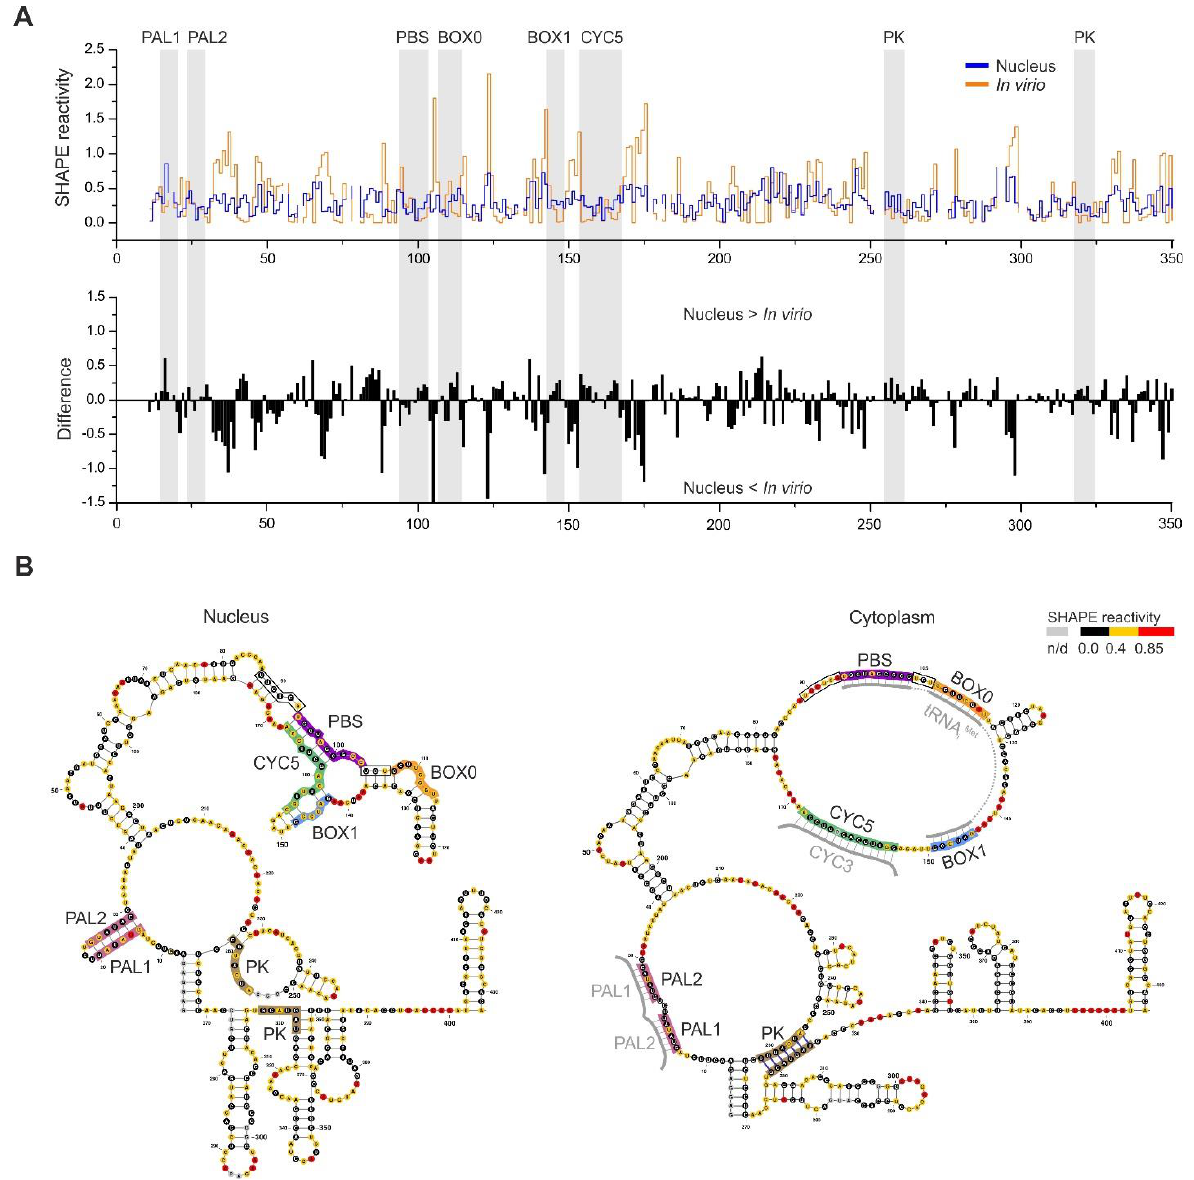
Figure 4. Comparative analysis of Ty1 gRNA regions containing cis-acting sequences. ( A ) The step plot (top) and the difference plot (down) calculated by subtracting the in virio NMIA reactivities from those of the nuclear Ty1 gRNA. ( B ) The MFE models of nuclear and cytoplasmic Ty1 gRNA 5′ end. Cis-acting sequences are marked with colored boxes. Neighboring regions affected by tRNA iMet annealing are boxed.